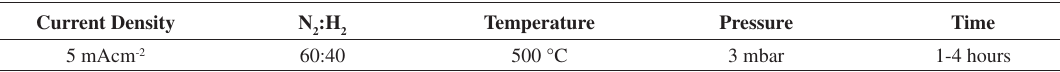
Table 2. Process parameters of active screen plasma nitriding. Current Density